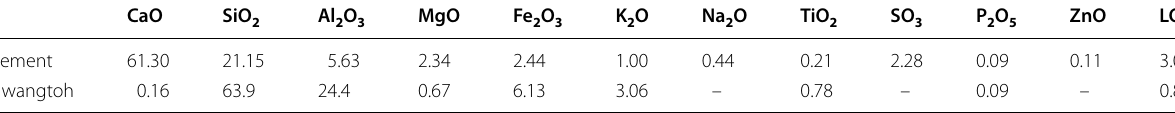
where W 105 is the weight at 105 ℃ .